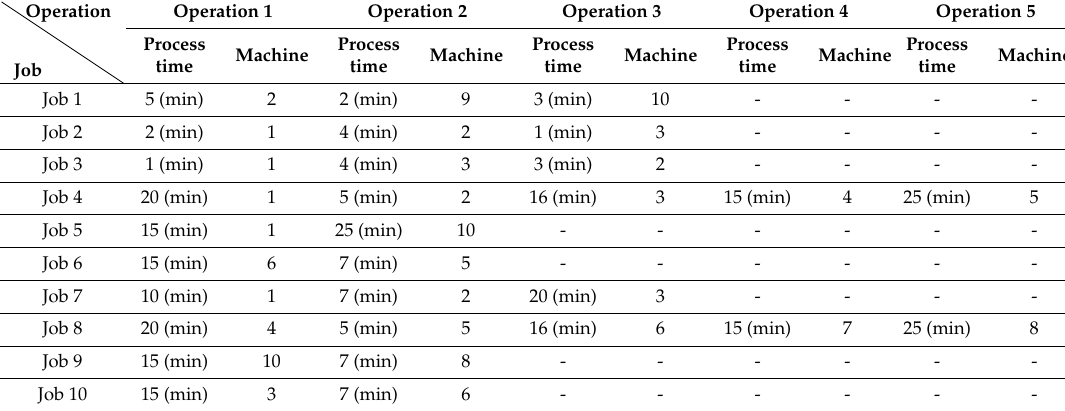
Table 1. Required machines and processing times of operations in the use case to execute the ACO